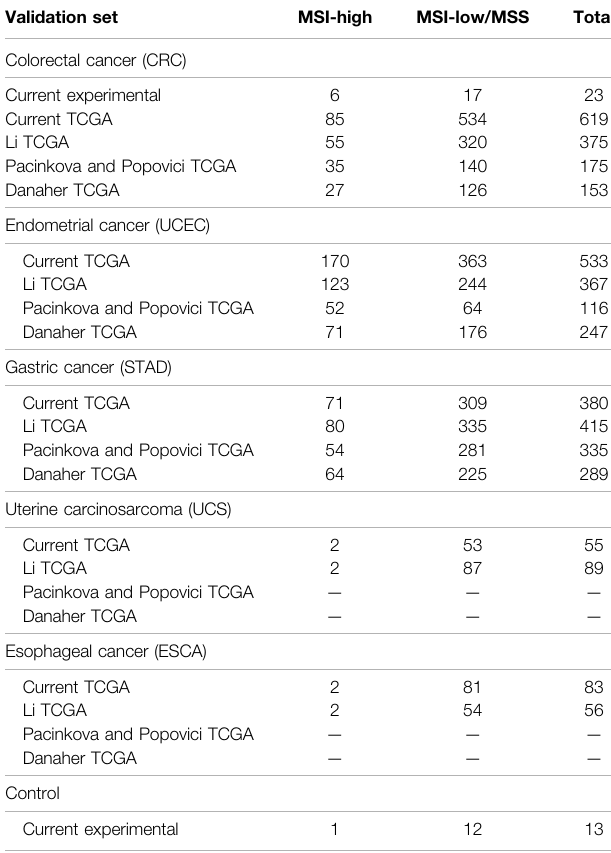
TABLE 1 | Characteristic of literature and experimental cancer patient